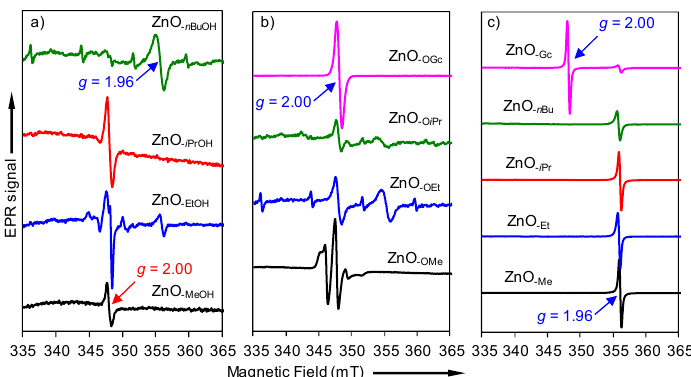
Figure 10. Room temperature EPR spectra of ZnO NPs derived from different synthetic approaches, for ( a ) ZnO -ROH ; ( b ) ZnO -OR ; and ( c ) ZnO -R (R = Me, Et, i Pr, n Bu and Gc).